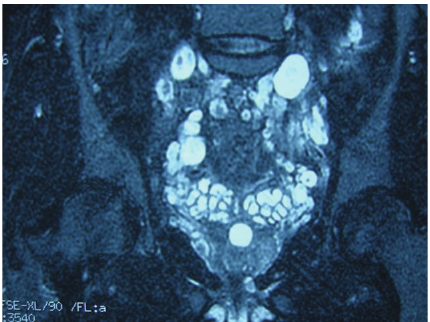
Figure 1: Coronal FSE fat-suppressed T2 weighted image:multiple ovoid-shaped high signal intensity neurofibromas are seen through- out the sacral and pelvic regions. Note that some neurofibromas demonstrate characteristic target sign.